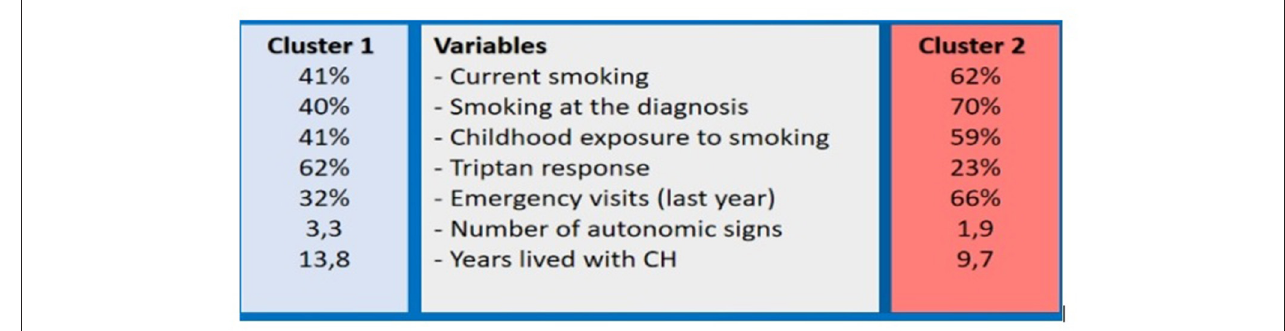
FIGURE 2 | The cluster 1 and 2 patients with Cluster Headache.